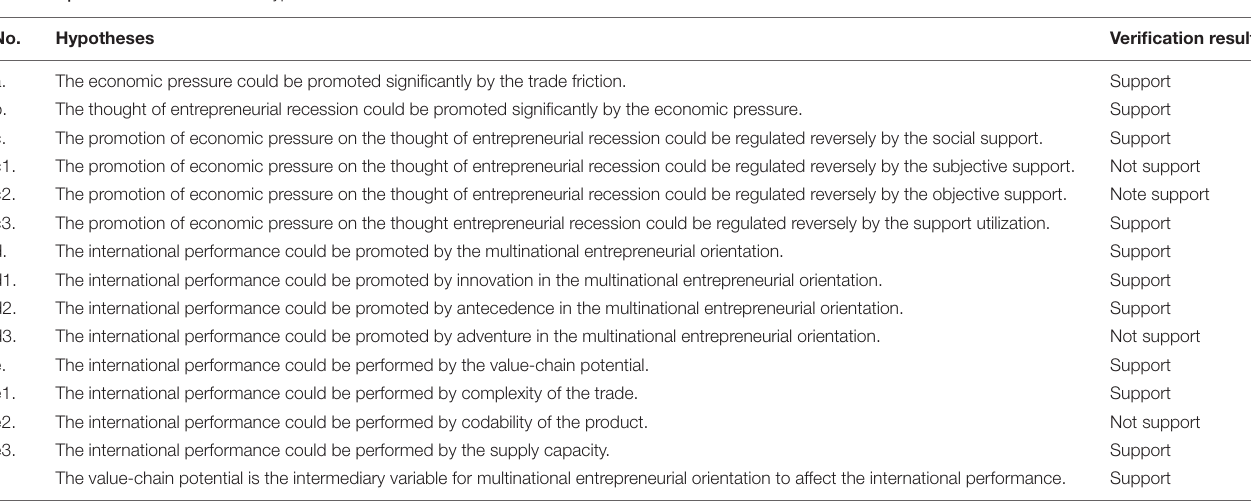
TABLE 8 | Verification results of the